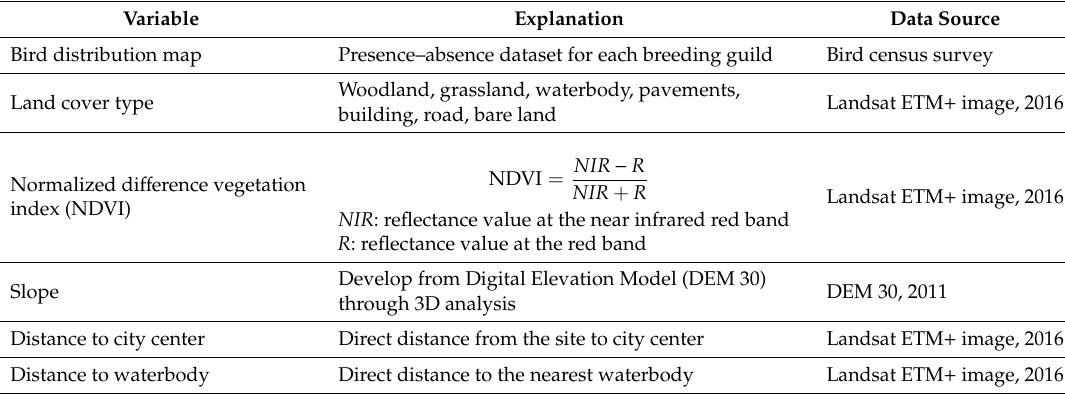
Table 1. Input variables for maximum entropy method (MaxEnt)